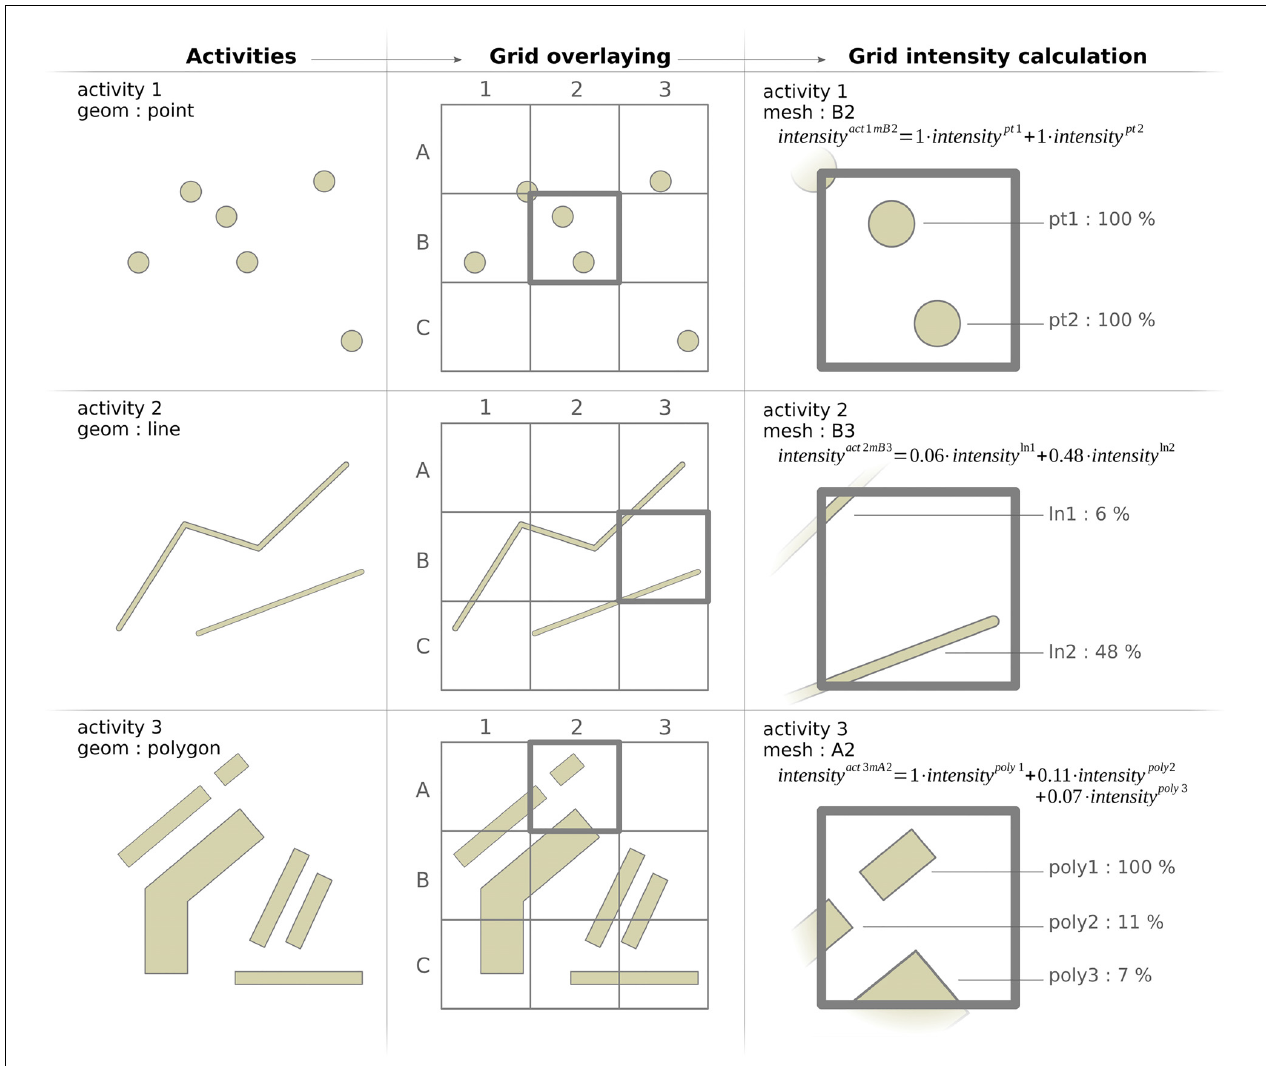
FIGURE 3 | Method of calculating the intensity of human activities into the grid.